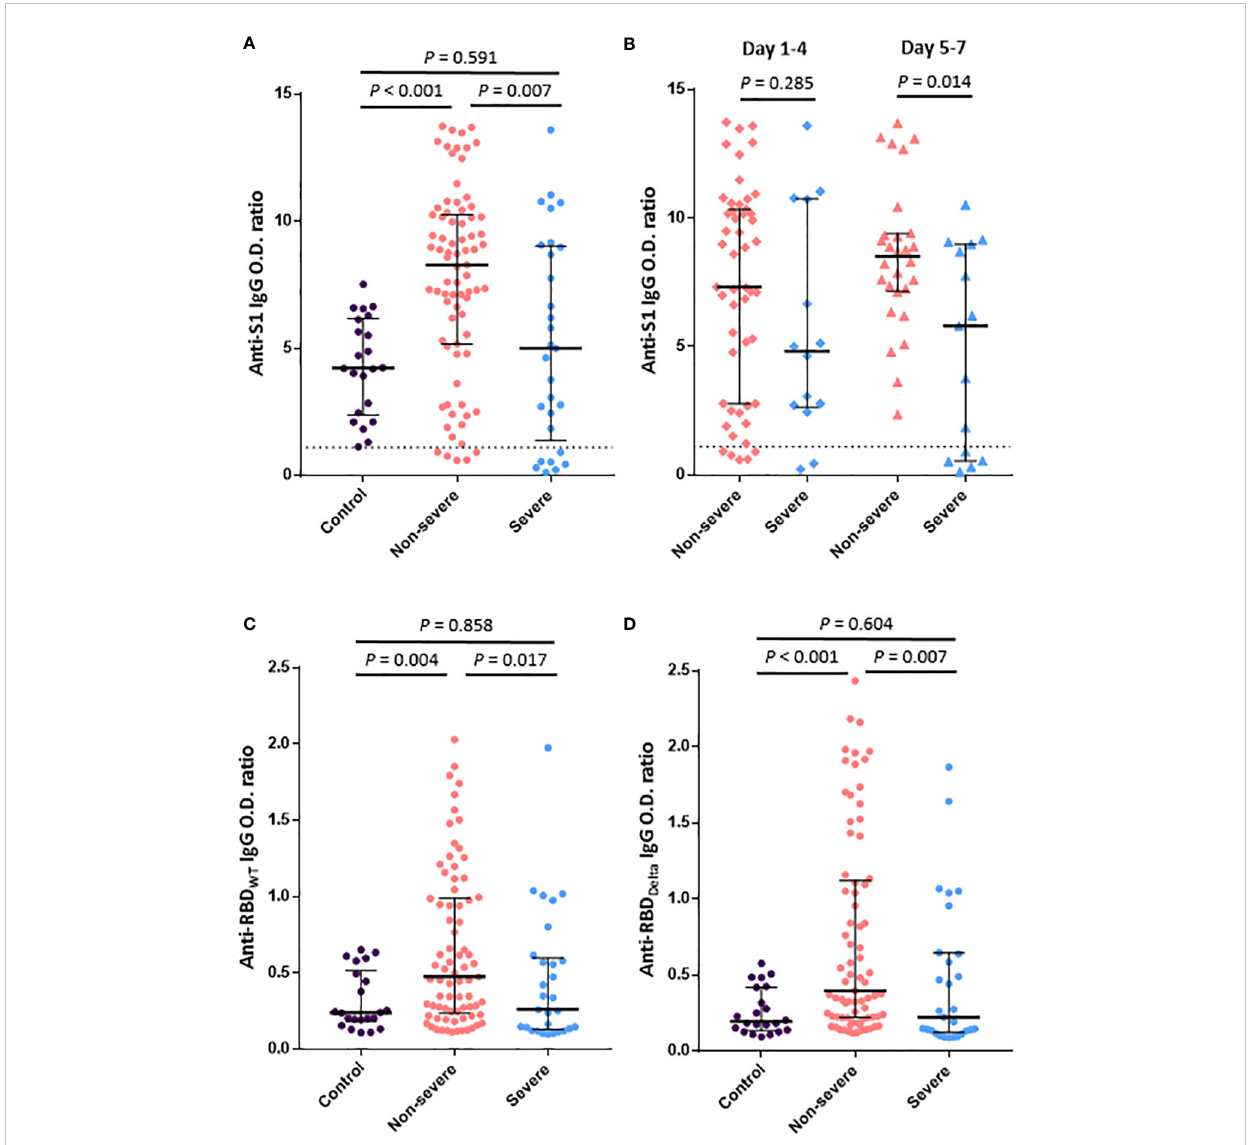
FIGURE 1 Humoral immune responses to SARS-CoV-2 within 1 week after symptom onset in patients with breakthrough COVID-19. (A) . Anti-S1 IgG antibody titers in the control (vaccinated subjects without infection), severe, and non-severe groups. (B) . Anti-S1 IgG antibody titers according to the number of days from symptom onset. (C) . IgG-binding activities to RBD WT . (D) . IgG-binding activities to RBD Delta . The dotted line shows the positive cutoff value of the anti-S1 IgG O.D. ratio. Vertical and horizontal lines indicate the median with the interquartile